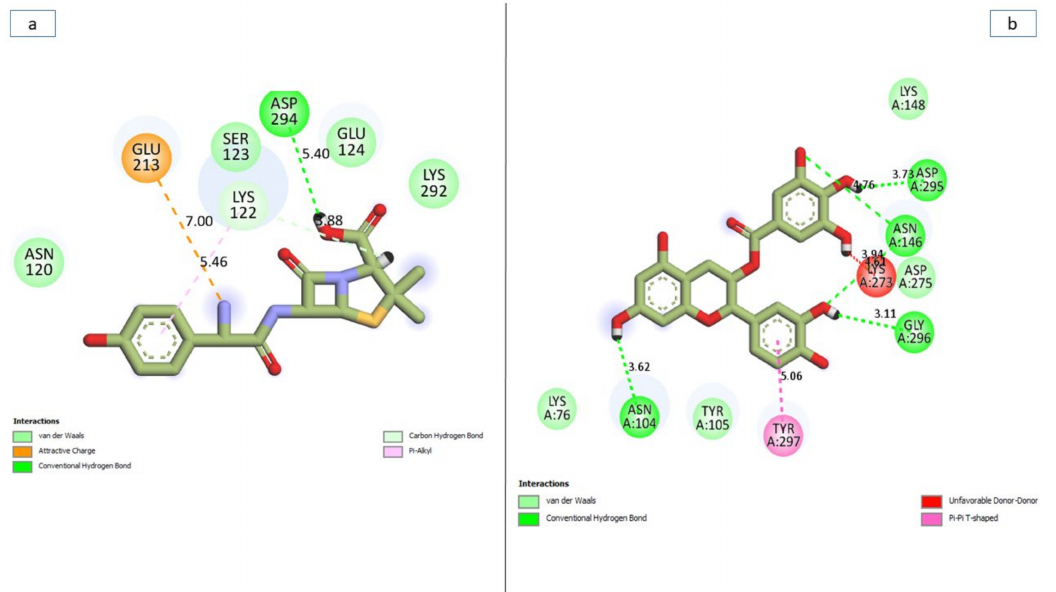
Figure 13. Plot of interactions of amoxicillin ( a ) and epicatechin gallate ( b ) against the allosteric site of PBP2a of S. aureus